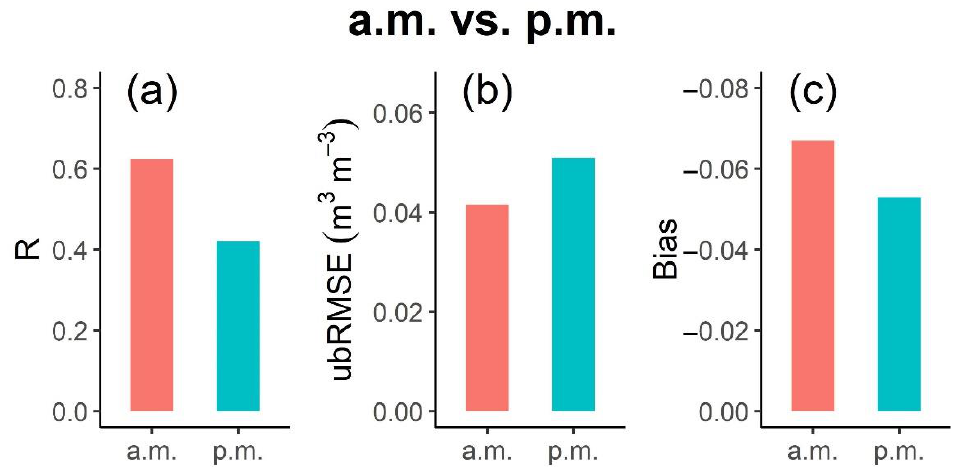
Figure 9. The averaged performance metrics (R ( a ), ubRMSE ( b ), and bias ( c )) for the SPL3SMP_E a.m. and p.m. SM estimates against the sparse network sites (across 34 validation sites).